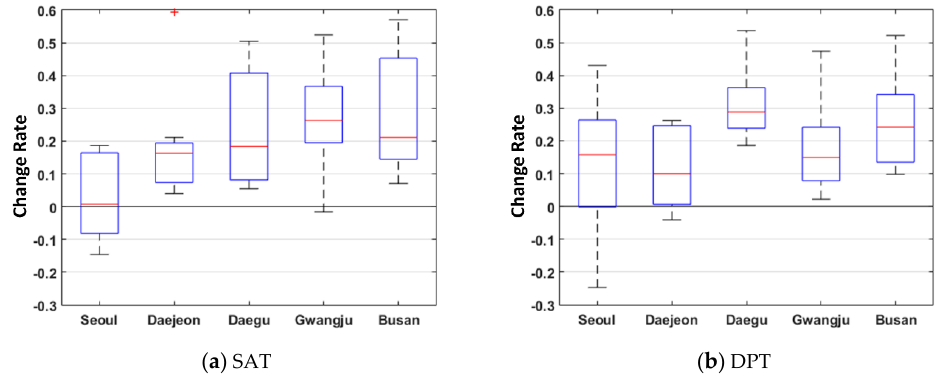
Figure 13. Change rate of annual exceedance daily rainfall depth.